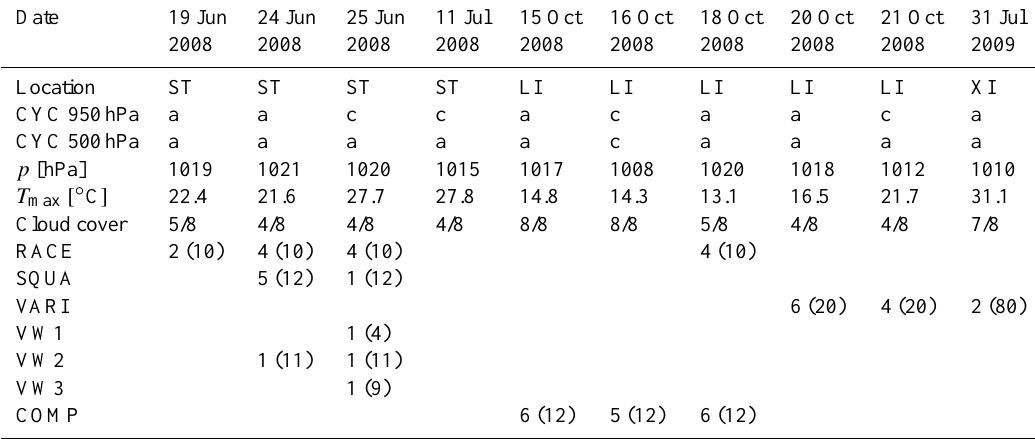
Table 3. Flight campaign summary for locations Lake Starnberg (ST), Lindenberg (LI), and Xilinhot (XI). Anticyclonic and cyclonic conditions are indicated by a and c, respectively. For the flight patterns racetrack (RACE), wind square (SQUA), variance optimization (VARI), vertical wind specific flights (VW1–VW3) and the comparison to ground based measurements (COMP) the number of available datasets for each date is given together with respective track length (km) in parenthesis. Additional information is given in Sect.